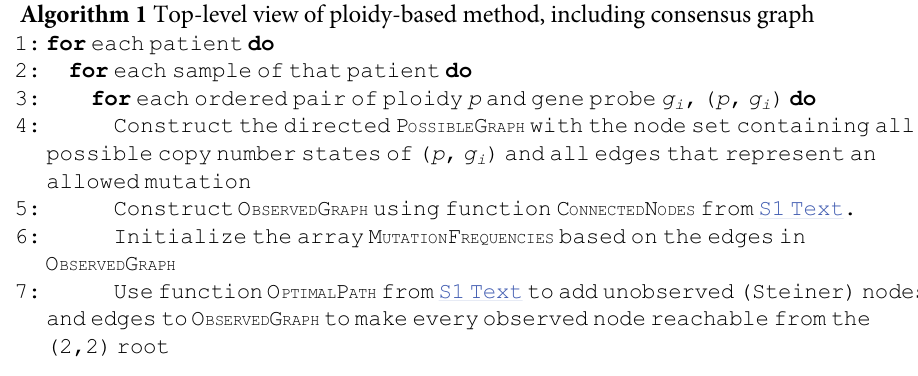
Algorithm 1 Top-level view of ploidy-based method, including consensus